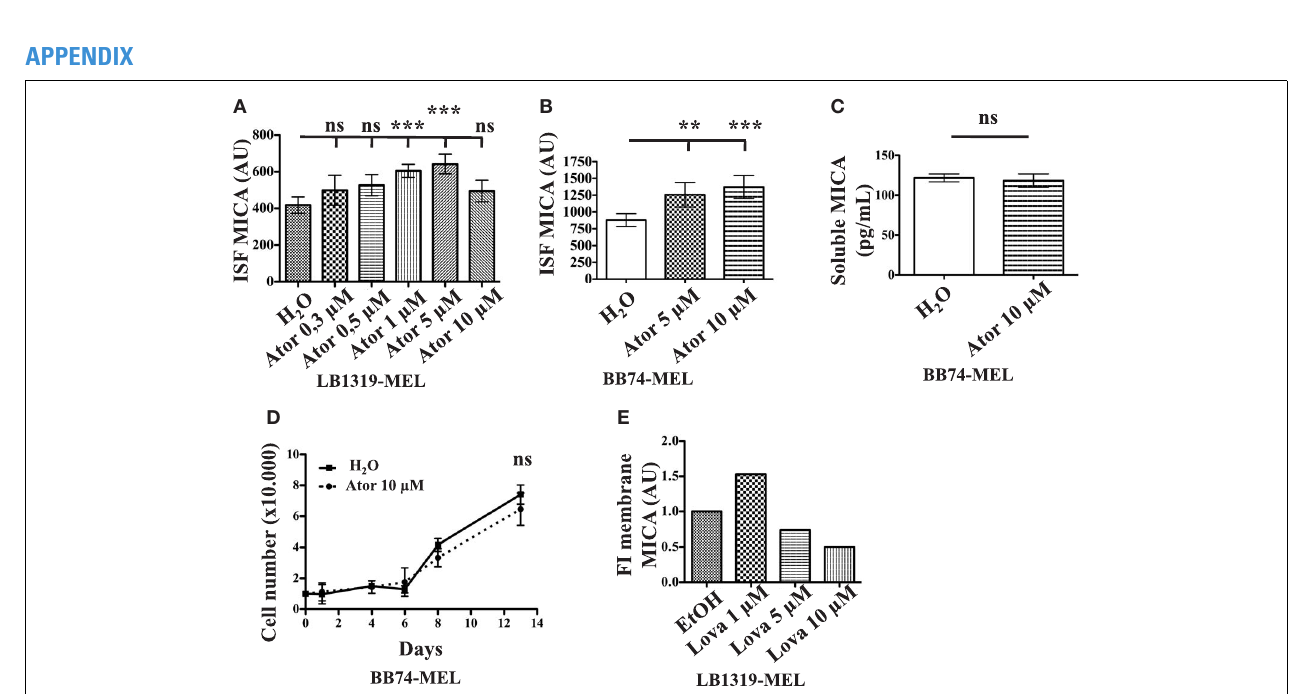
cleavage by ELISA (C) . ** P < 0.01; *** P < 0.001; versus control condition using theTukey ANOVA test. Every 2–3days pretreated (Ator) and untreated (H 2 O) BB74-MEL cells were counted to evaluate the in vitro proliferation (D) . ns; versus control condition using the two-way ANOVA test. LB1319-MEL cells were treated with increasing concentrations of lovastatin and membrane MICA expression was analyzed (E) .